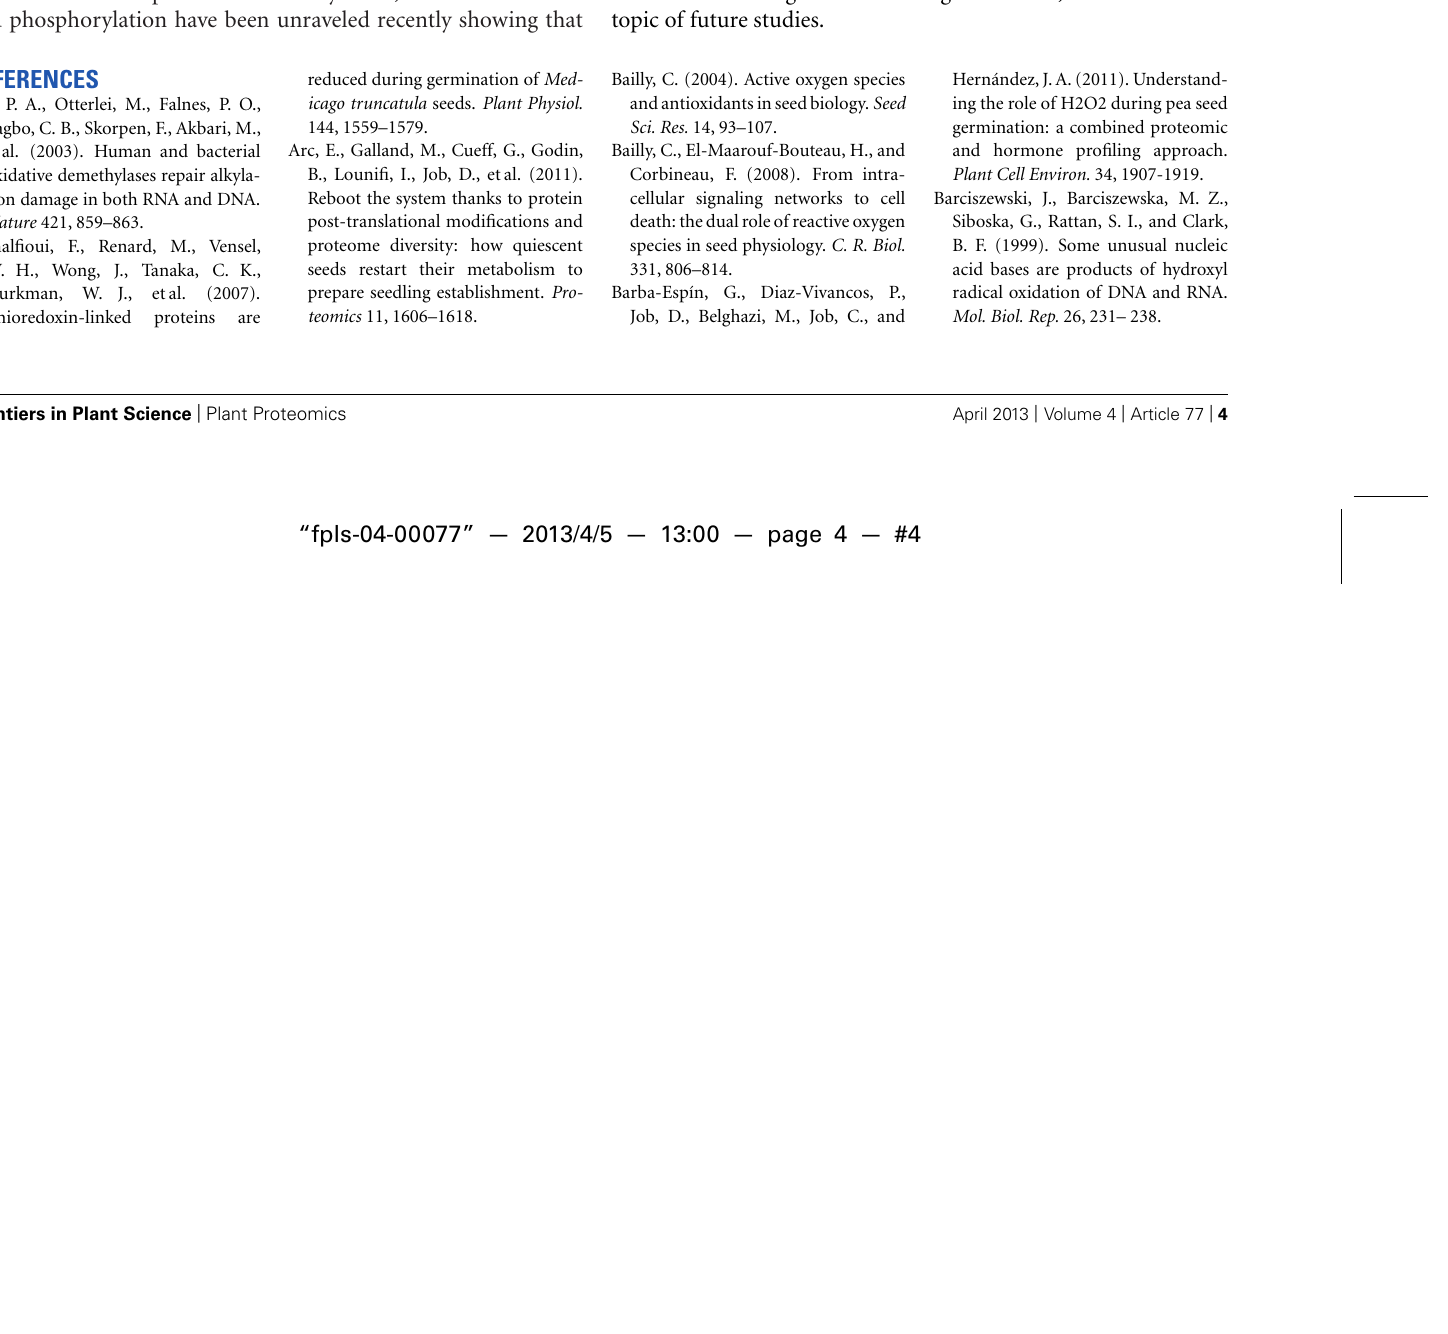
FIGURE 1 | Role of mRNA and protein oxidation in seed germination. During non-dormant seed imbibition, ROS, accumulated during dry after-ripening or produced during imbibition, trigger selective oxidation of mRNA and proteins. Oxidation of mRNAs leads to their decay through the action of P-bodies and/or to the alteration of translation. Proteins can be irreversibly oxidized by carbonylation, which leads to their cytosolic degradation through the 20S proteasome. Oxidation of cysteine and